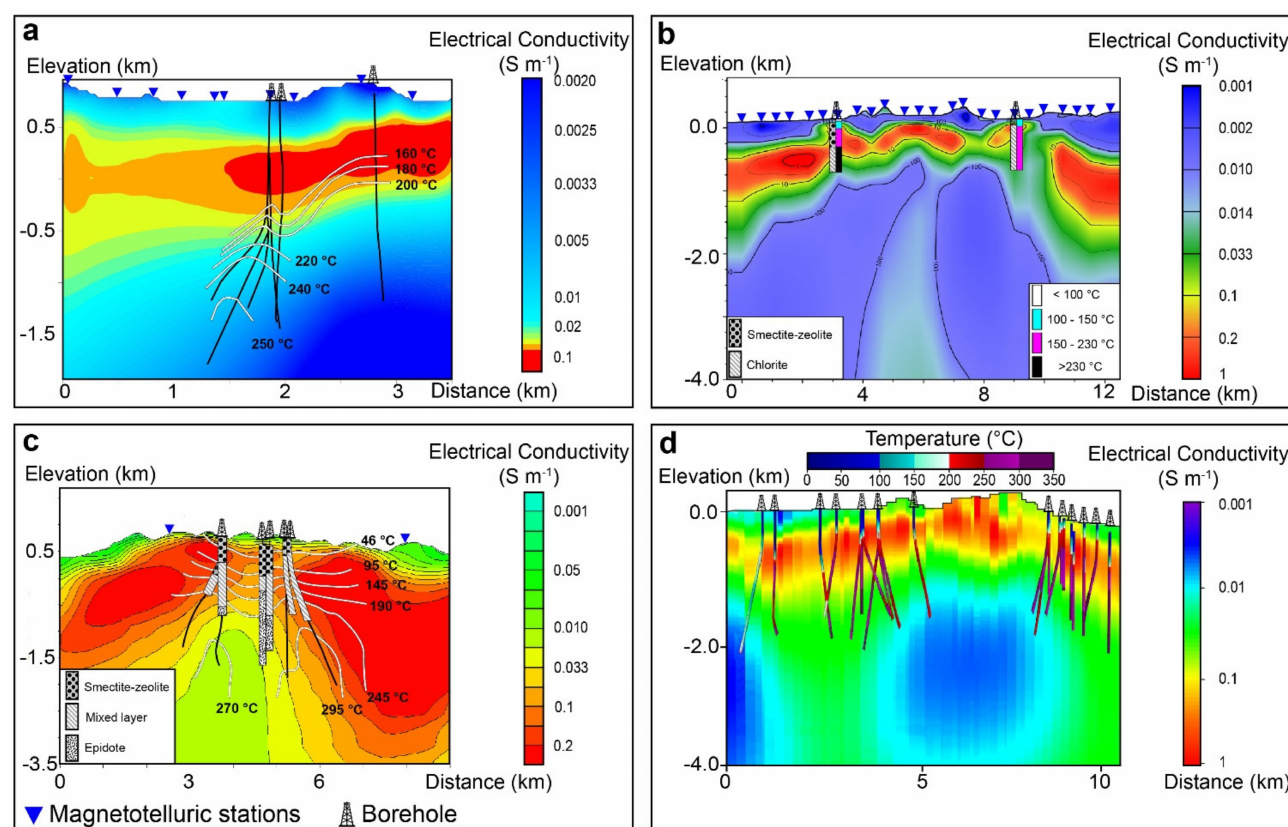
Figure 10. Electrical conductivity cross sections superimposed with rock lithology and temperature in boreholes. ( a ) Takigami geothermal area (modified after Ushijima et al. [81]). ( b ) Kr ý suv í k geothermal area, Iceland (modified after Hersir et al. [82]). ( c ) Bacon-Manito geothermal area, Philippines (modified after Tugawin et al. [83]). ( d ) Hengill geothermal fields, Iceland (modified after Gasperikova et al. [84]). Shallow resistive regions (<0.01 S · m − 1 ) are associated with cold (<50 ◦ C) and unaltered rocks, while conductive formations (0.1–1 S · m − 1 ) correspond to a recognized smectite rich clay-cap with moderated-high temperatures (50–220 ◦